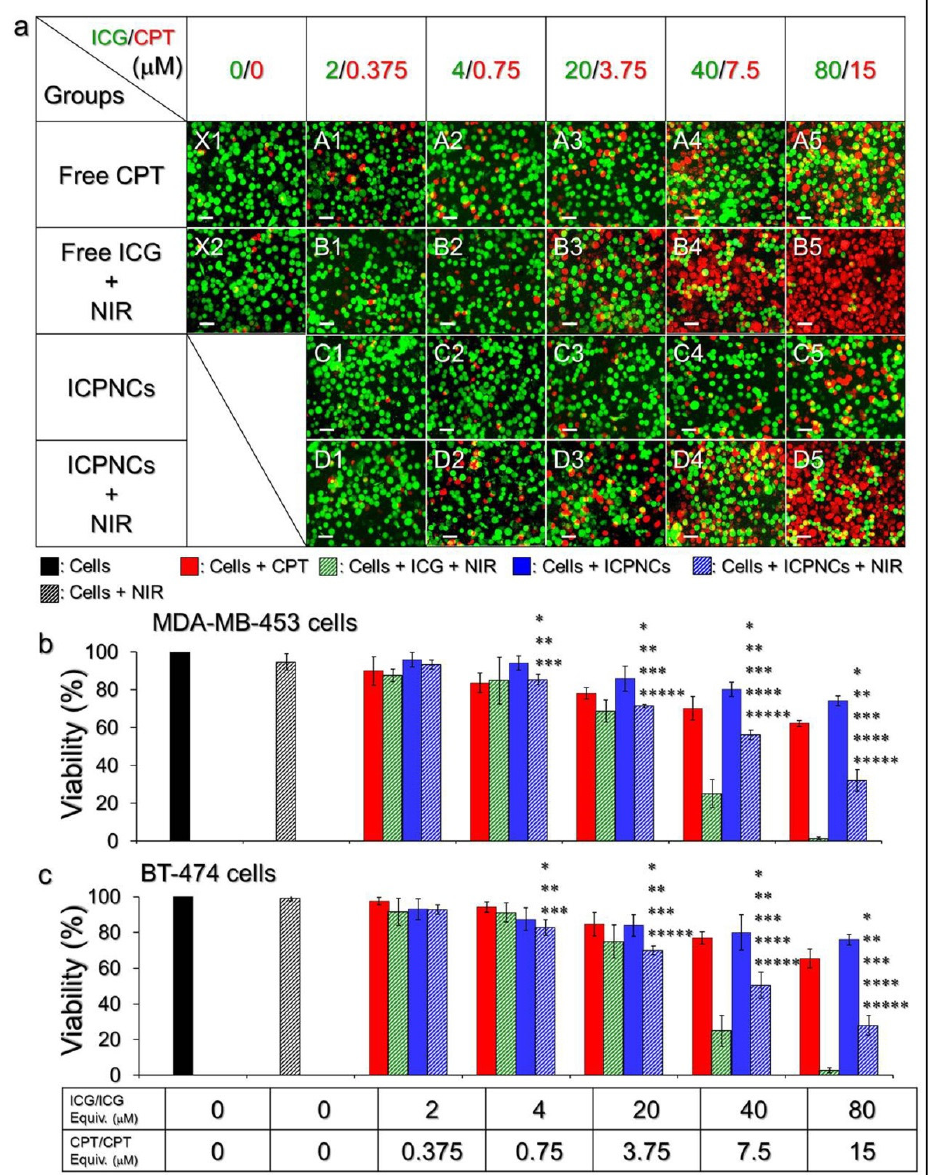
Figure 3. Cytotoxicity of the ICPNCs to breast cancer cells in vitro. ( a ) Photomicrographic images of MDA-MB-453 cells under various treatments. Rows A–D represent the groups treated with CPT, free ICG + NIR, ICPNCs, and ICPNCs + NIR, respectively, in which the concentrations of ICG and/or CPT (ICG/CPT) were set as 2/0.375, 4/0.75, 20/3.75, 40/7.5, and 80/15 μ M as indicated in the figure. NIR irradiation was performed using an 808-nm laser with an output intensity of 6 W/cm 2 for 5 min. ×1 denotes the cells with neither drug nor NIR exposure. ×2 represents the cells treated with NIR exposure for 5 min followed by incubation at 37 °C for 24 h. The green and red cells stained by calcein-AM and propidium iodide represent live and dead cells, respectively. All images were photographed using a fluorescence microscope at 200X magnification. Scale bar = 30 μ m. ( b , c ) Quantitative analyses of the viabilities of MDA-MB-453 ( b ) and BT-474 ( c ) cells after treatment with different conditions as indicated on the X-axis. Values are mean ± s.d. ( n = 3). * p < 0.05 compared to the group without treatment. ** p < 0.05 compared to the group with NIR exposure alone. *** p < 0.05 compared to the group with equal concentration of free CPT. **** p < 0.05 compared to the group with free ICG + NIR under equal concentration setting. ***** p < 0.05 compared to the group with equal dose of ICPNCs without NIR irradiation.